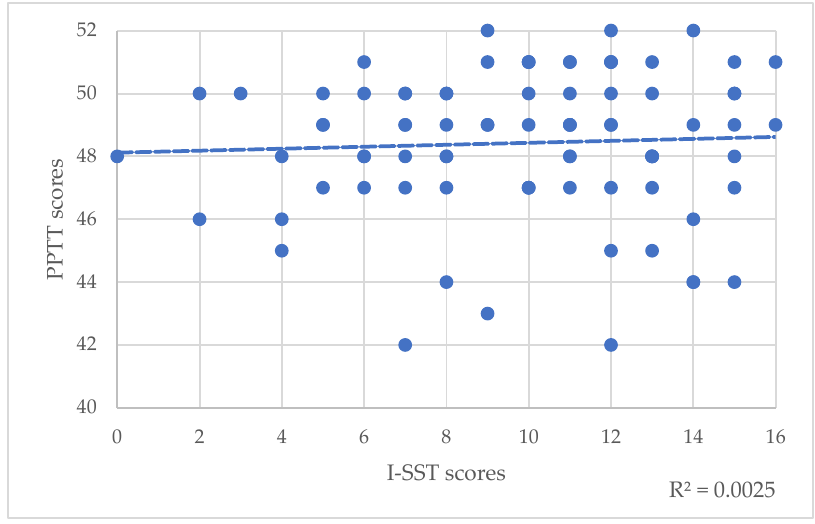
Figure 3. Correlations between PPTT scores and I-SST scores. The dotted line represents the trend line. Out of the 17 patients with a PPTT score below the cut-off score, 9 had a T score of the SST below the cut-off score and 3 with a D score below the cut-off score. 2 of them